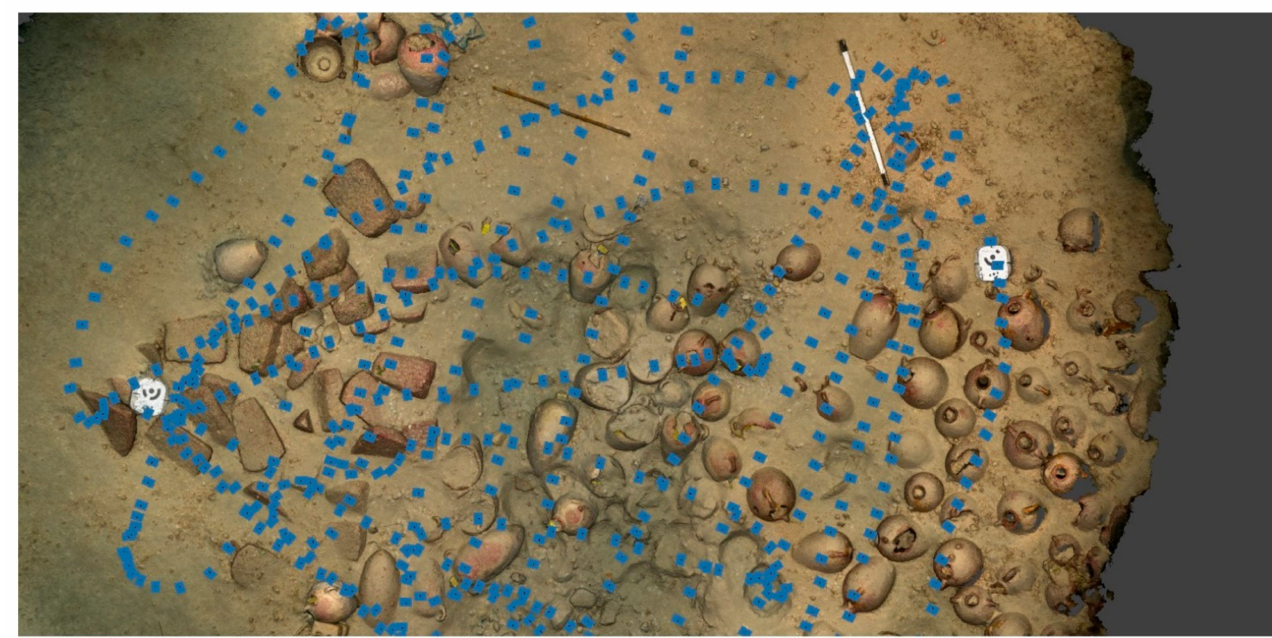
Figure 2. Blue markers represent the locations where an image was taken, highlighting a typical route taken by divers for data capture on the Phoenician shipwreck site. A one-meter scale can be seen in the top right.